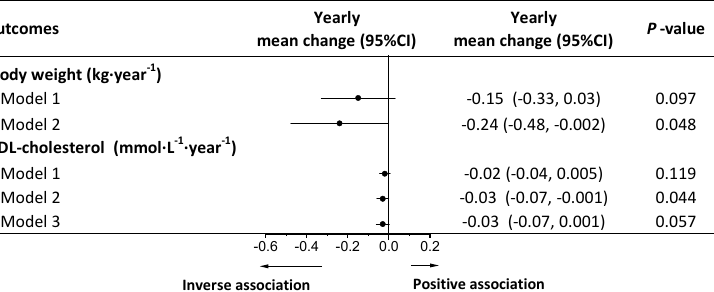
Figure 2. Longitudinal associations of adherence to a plant-based diet with yearly weight regain and changes in cardiometabolic risk factors during weight-loss maintenance. Yearly mean change and 95% CI of main effects indicating changes in body weight or cardiometabolic risk factors per year associated with a 1 standard deviation increment in plant-based diet index. Analyses were conducted using a linear mixed model with repeated measures. Model 1 was adjusted for fixed factors including age, sex, ethnicity, BMI at 8 weeks, body weight, or cardiometabolic risk factors at 8 weeks, and time and random factors including study center and participant ID. Model 2 was adjusted for covariates in model 1 plus fixed factors including time-varying physical activity, energy intake (kJ · day − 1 ), alcohol intake (g · day − 1 ). Model 3 was adjusted for covariates in model 2 plus time-varying yearly changes in body weight as a fixed factor. LDL cholesterol, low-density lipoprotein cholesterol.